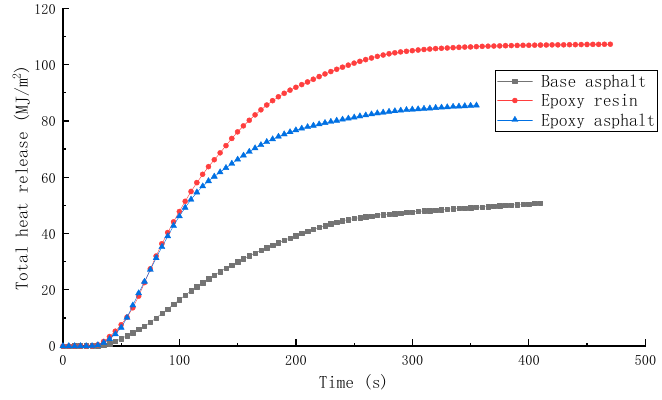
Figure 8. THR of different materials.